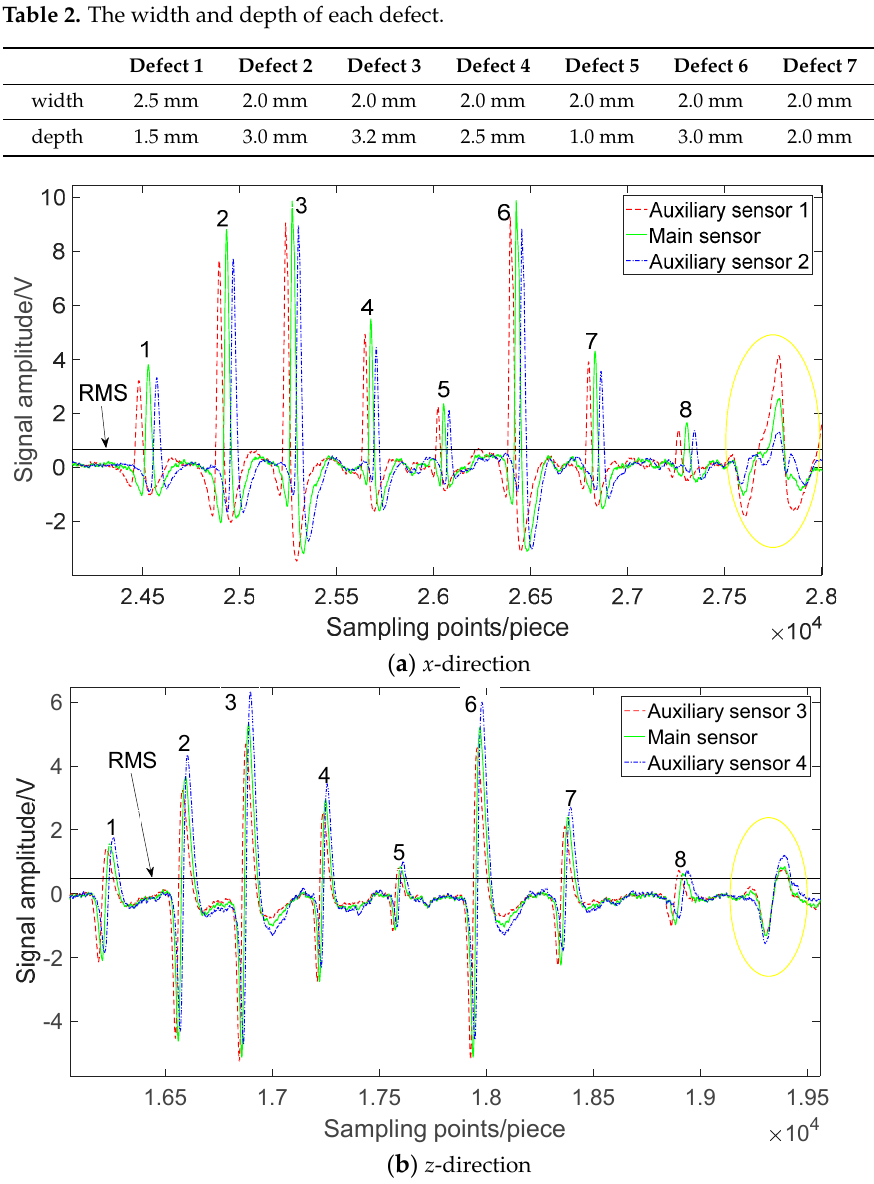
Figure 16. Detection results of damage